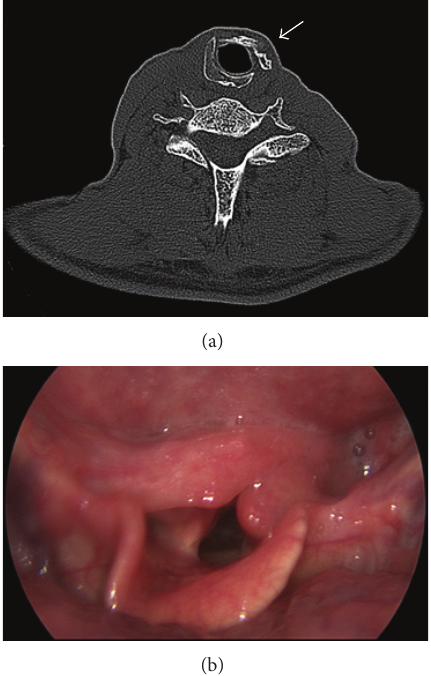
Figure 3: (a) CT scan showing thyroid cartilage used for recon- struction (arrow). (b) Videolaryngoscopic image showing adequate airway